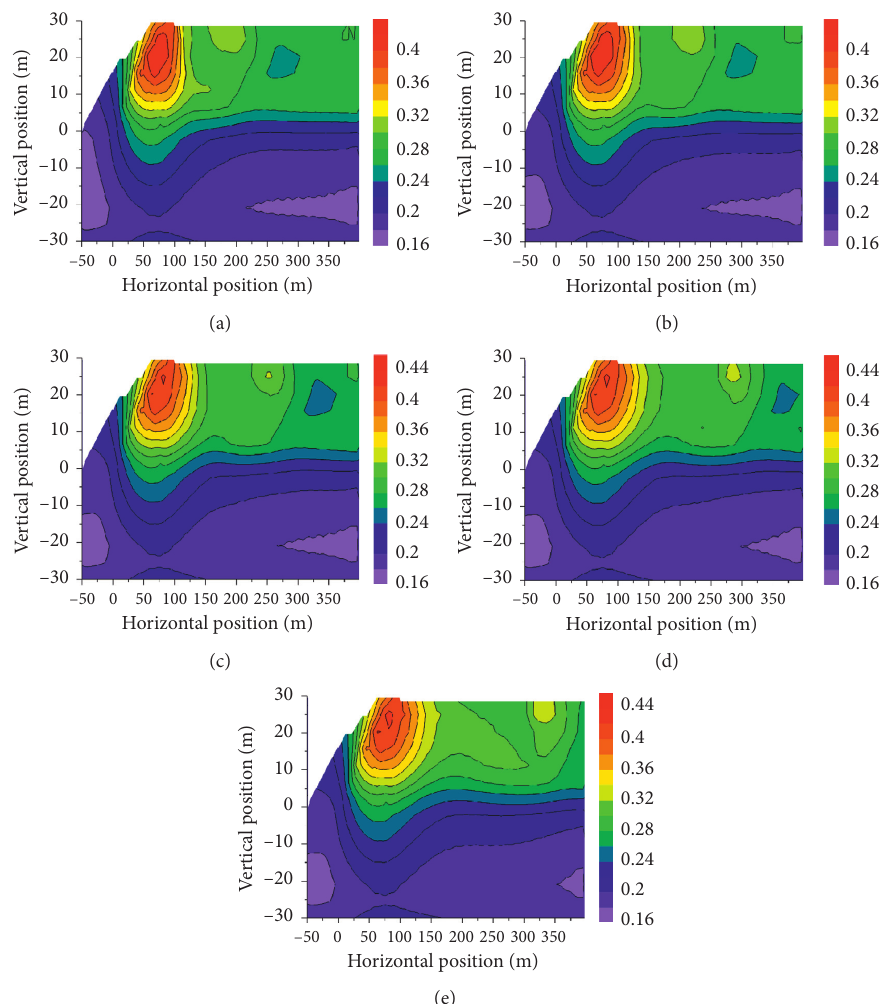
Figure 5: Contour of acceleration of various parts of the ash storage field. (a) L (e) L d �